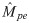
Data set M vs. v6M (or 10−2
D) and the model outputs M^pe and M^1 for men patients’ population.